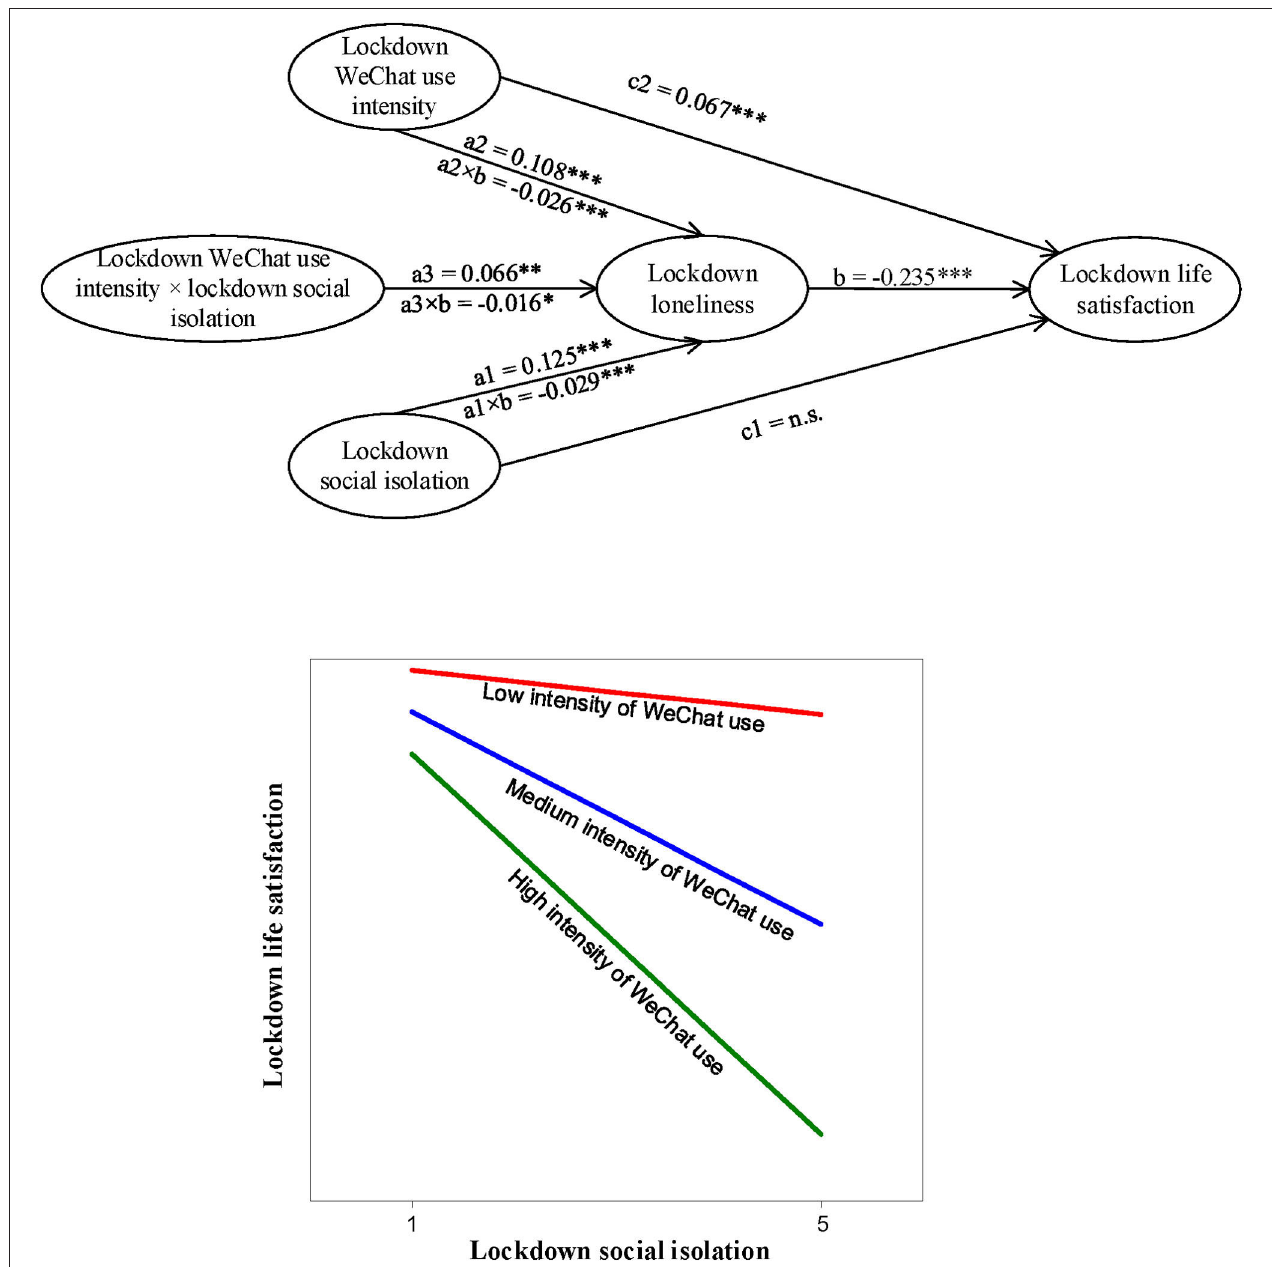
FIGURE 3 | A graphical illustration of parameter estimates and moderation by intensity of WeChat use (lockdown life satisfaction as dependent variable). Number of Free Paramaters = 53, LL = − 28308.964, AIC = 56723.929, * p < 0.05, ** p < 0.01, *** p < 0.001, n.s. not significant. n = 1805. Note.—The indirect effect of Lockdown Social Isolation on Lockdown Life Satisfaction is conditional on Intensity of WeChat Use: (a1 × b) + (a3 × b) × Lockdown WeChat use